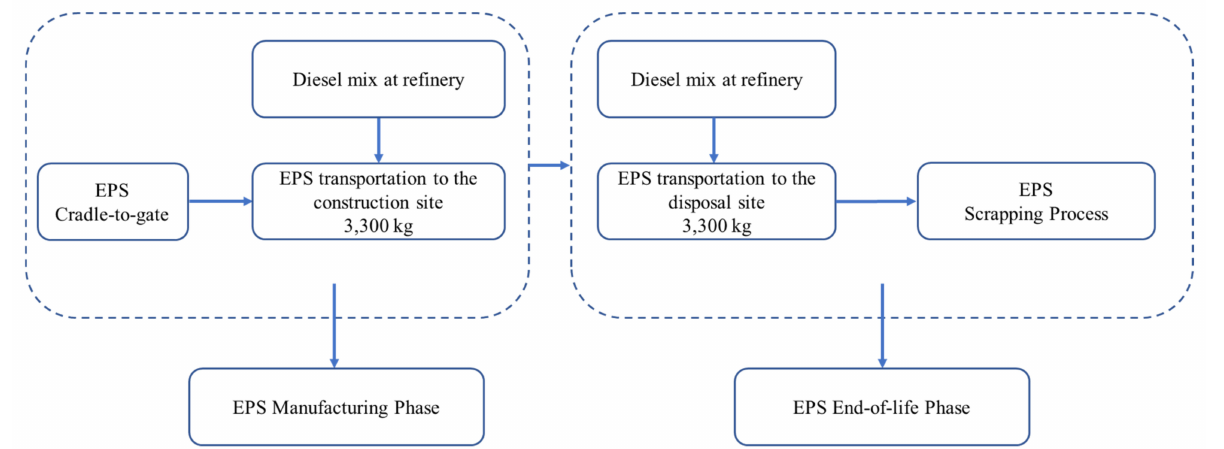
Figure 8. Flow diagram of